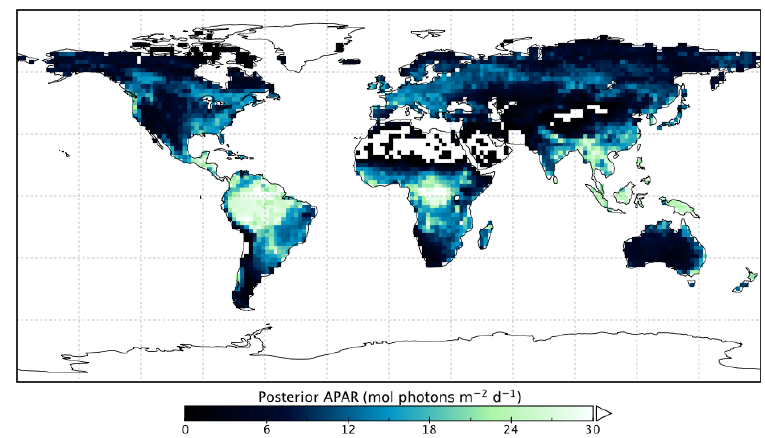
Figure B5. Posterior annual mean APAR following the SIF